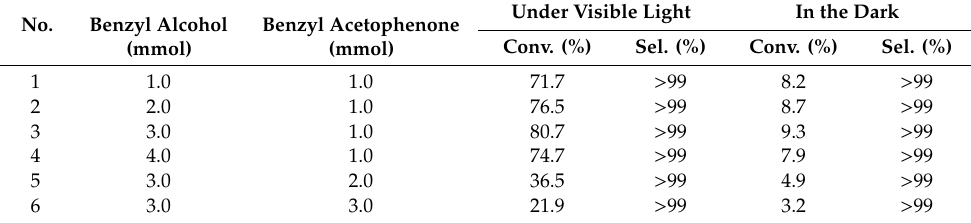
Table 7. E ff ect of di ff erent amounts of reactants on the reaction of benzyl alcohol and acetophenone.